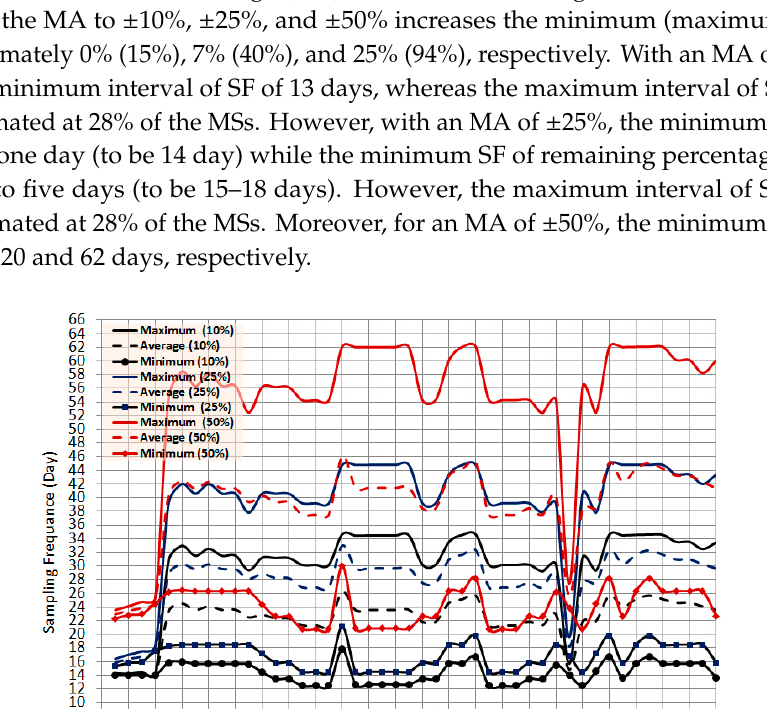
Figure 9. Minimum, average and maximum interval of sampling frequency (SF) of the 46 monitoring stations (MSs), with monitoring accuracies (MA) of ± 10%, ± 25%, and ± 50%. Figure 10. Relationship of SF versus MA.